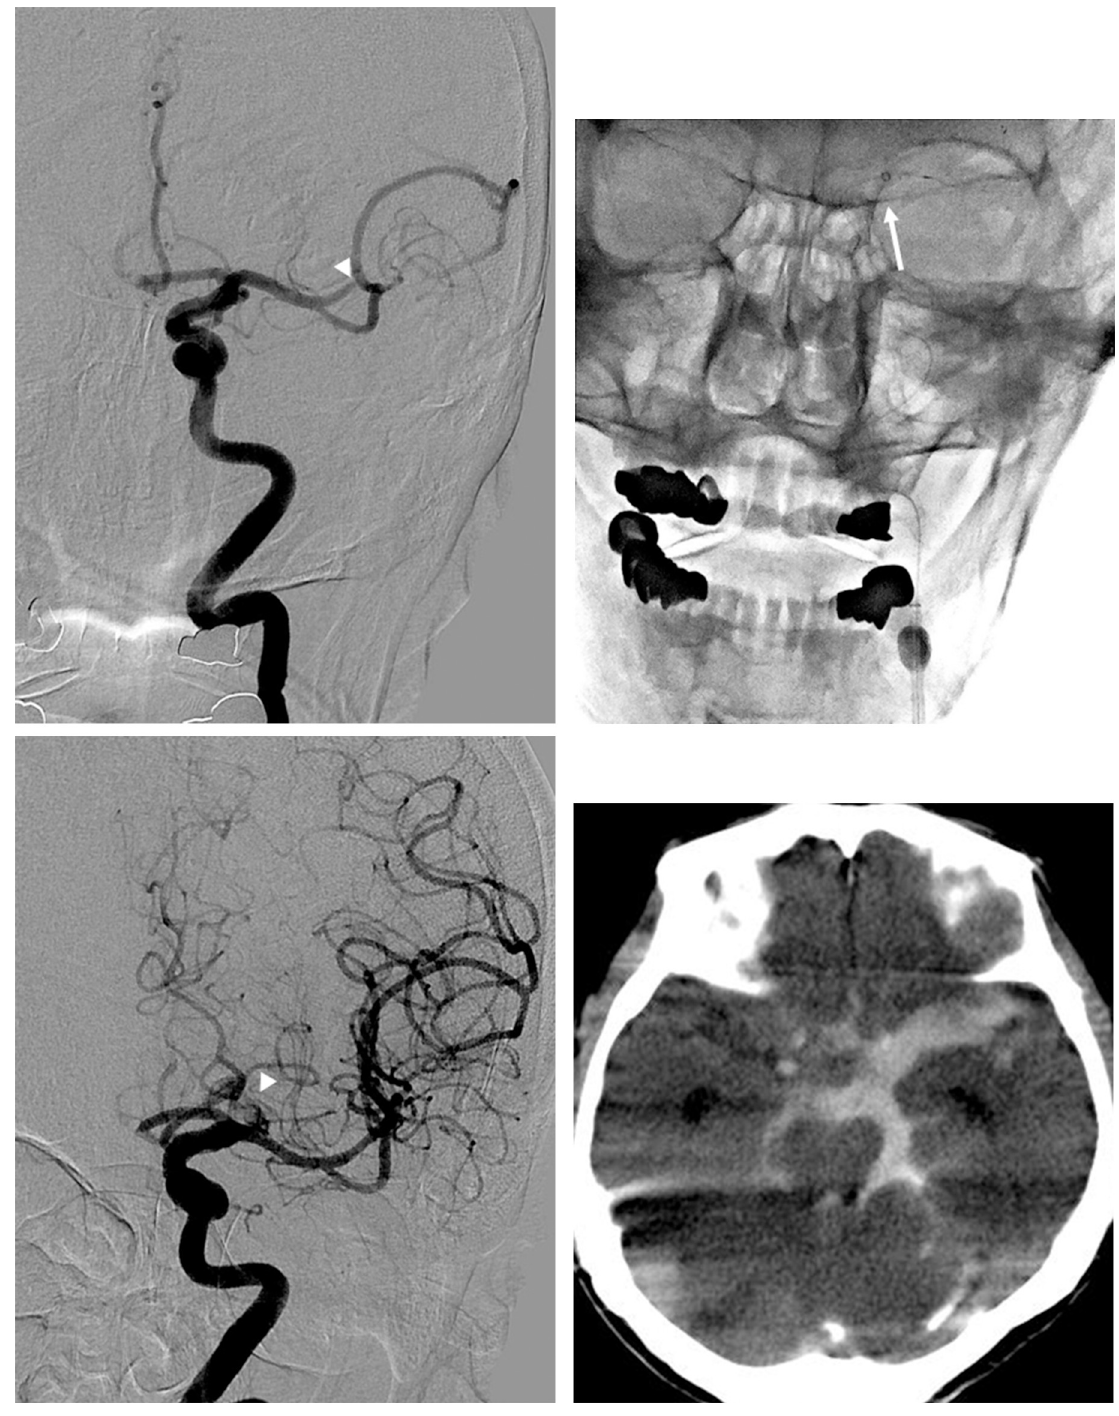
Fig 3. An 87-year-old man, who presented with acute stroke and an initial NIHSS score of 18. (A) Left anteroposterior internal carotid artery angiogram shows occlusion of the proximal superior trunk of the middle cerebral artery (arrowhead). (B) The advancement of the distal access catheter (DAC) in the middle cerebral artery was very difficult. The DAC was advanced in the proximal middle cerebral artery (arrow). (C) Post-thrombectomy anteroposterior internal carotid artery angiogram shows complete reperfusion of the middle cerebral artery; however, there is contrast extravasation (arrowhead) in the left proximal middle cerebral artery. (D) Postoperative axial CT shows subarachnoid hemorrhage.